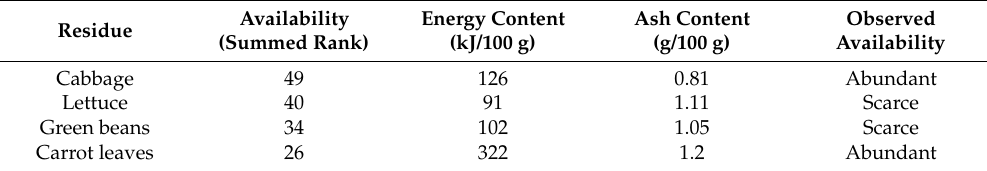
Table 3. Selection criteria for